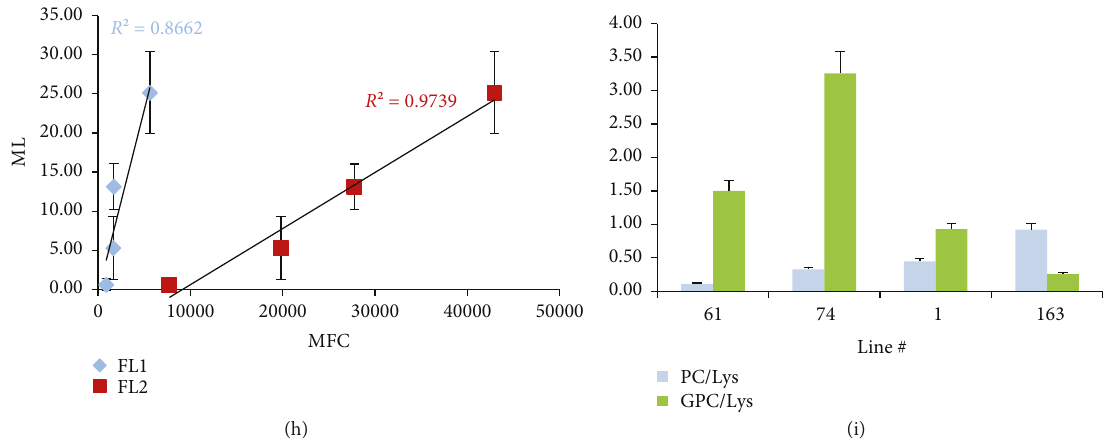
Figure 3: Intracellular lipid droplets are detected by MRS and by ME mainly in GSCs of cluster 2. (a) Characteristics of the selected four GSC lines: metabolic and phenotypic cluster classi fi cation; progression-free survival (PFS) and overall survival (OS) of the corresponding patients; doubling time (DT) of GSCs in culture; (A ′ ) in vitro growth curves of the four di ff erent GSC lines. Confocal microscopy images (b – e) and mobile lipid (ML) signal region from 1D 1H MR spectra (B ′ , C ′ , D ′ , and E ′ ) of GSC lines #61, #74, #1, and #163, respectively; (f) mean fl uorescence values (MFC), FL1 and FL2 channel, from Nile red-stained GSC samples analyzed by fl ow cytometry; (g) mean values (and SE) of mobile lipid signals from 1D (ML) and 2D COSY (cross peak A) MR spectra (at least three experiments for each GSC line); (h) linear correlation between fl uorescence values and ML signal intensities; (i) mean values (and SE) of PC and GPC values as obtained from 2D